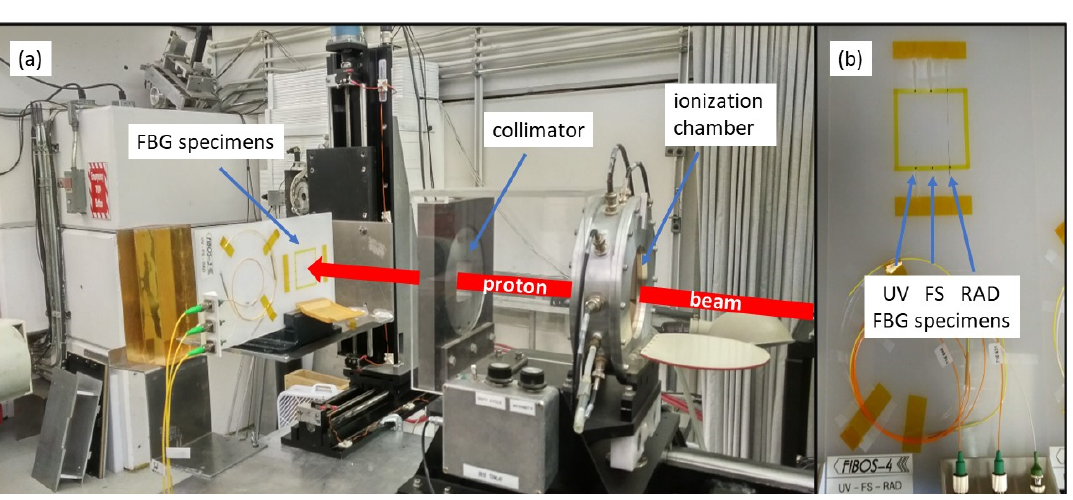
Figure 2. ( a ) TRIUMF experimental setup. FBG test specimen at left of image with proton beam line proceeding from right to left. ( b ) Example of UV, FS and RAD grating specimens mounted on plastic placard. Table 1. Proton and neutron irradiation experiments.